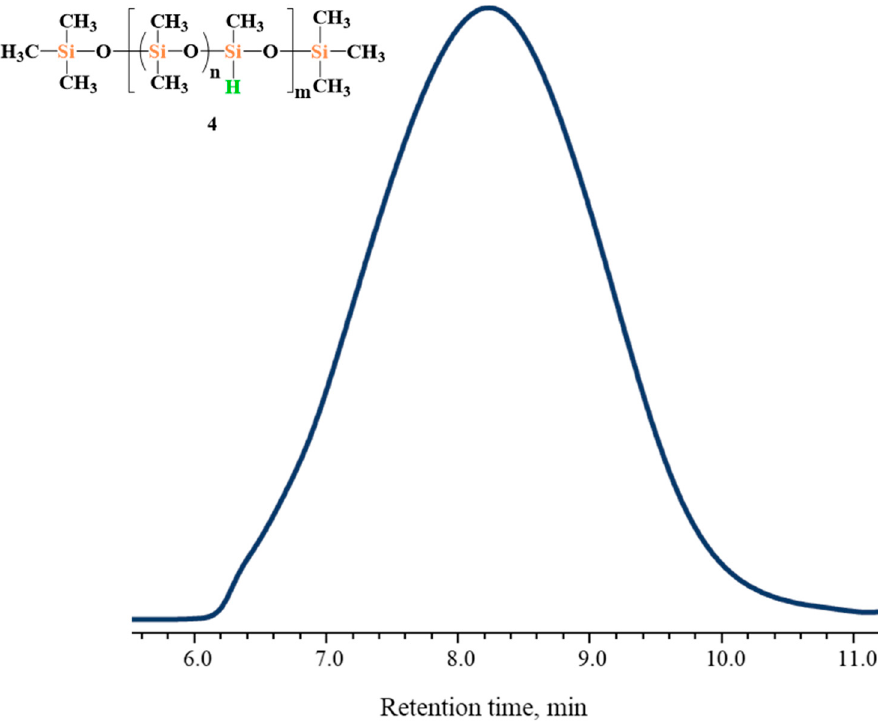
Figure 1. GPC curve of polymer 4 obtained in toluene using column Phenogel 10 4 Å.